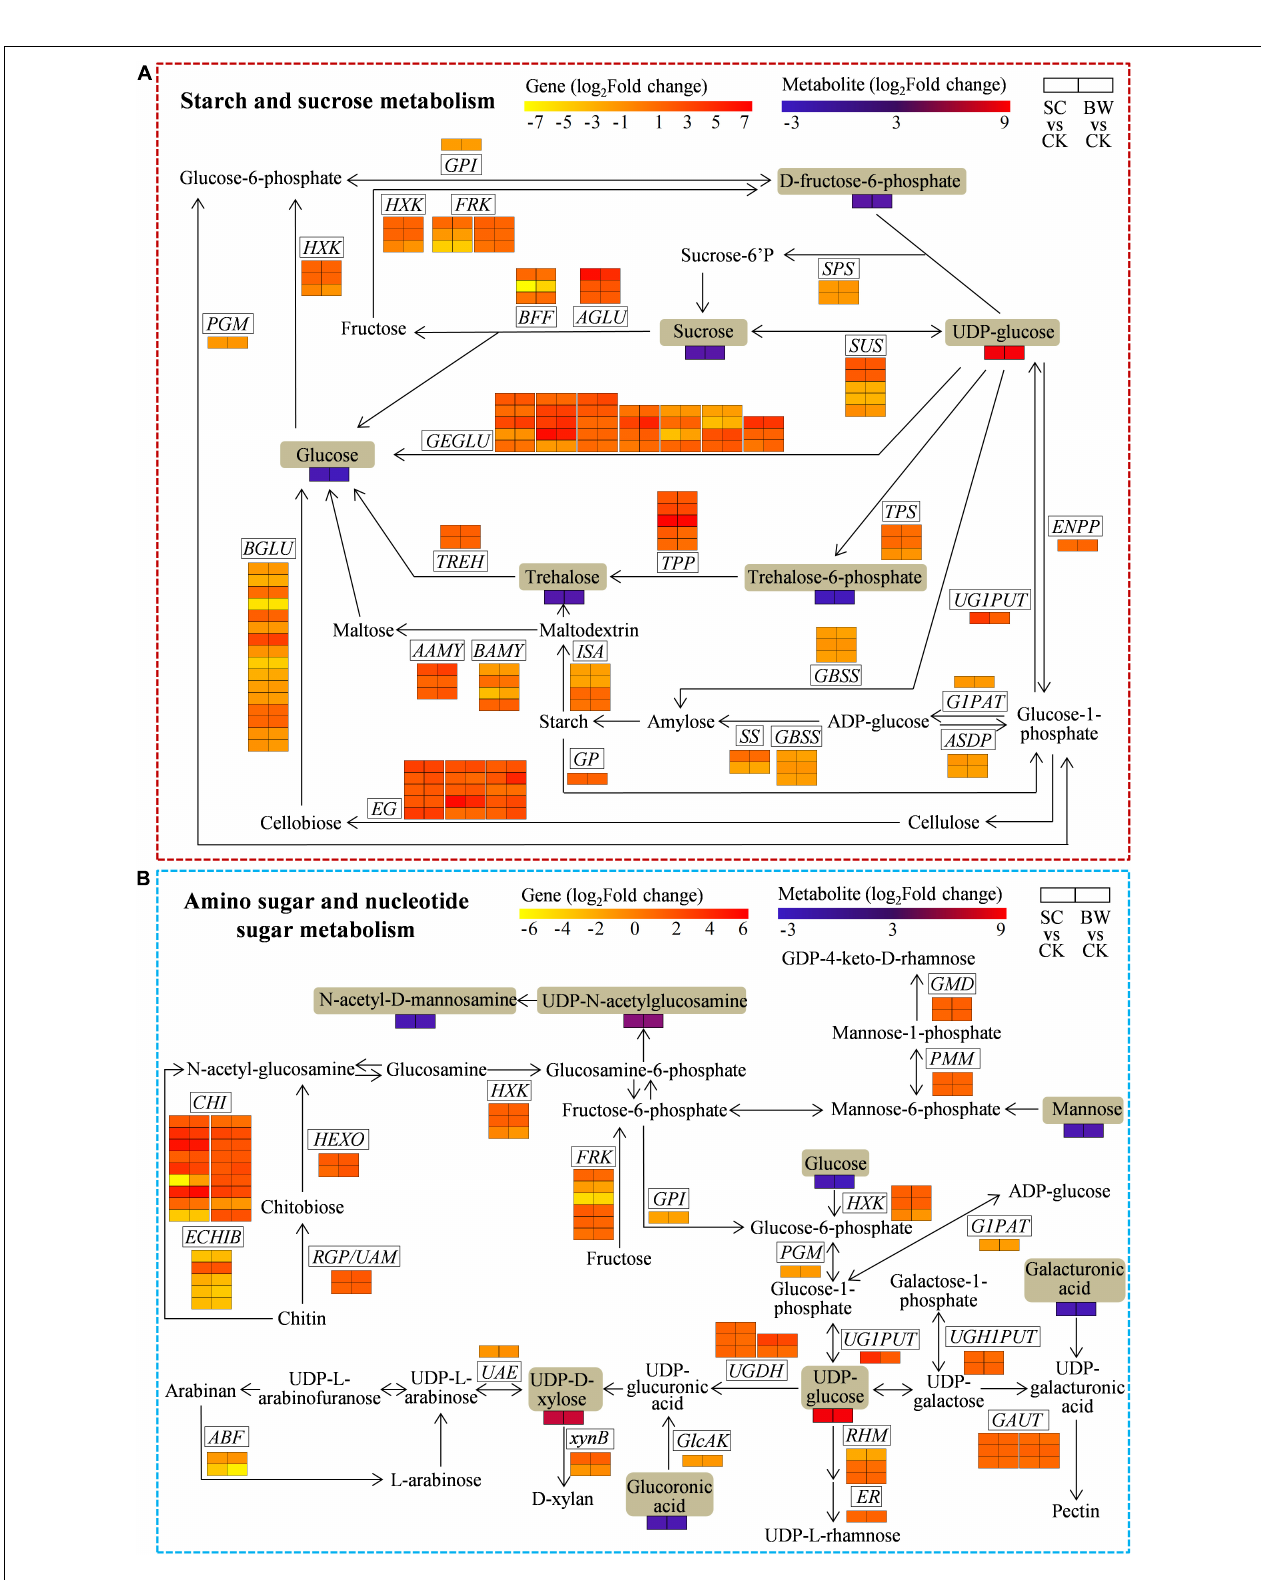
FIGURE 5 | The DEGs and DAMs involved in (A) starch and sucrose metabolism and (B) amino sugar and nucleotide sugar metabolism during the seed initial imbibition under salt stress. The brown background indicated the DAMs that changed under salt stress. The rectangular color block was equally divided into two parts, of which the left represented DEGs or DAMs in SC vs. CK, and the right represented DEGs or DAMs in BW vs. CK.